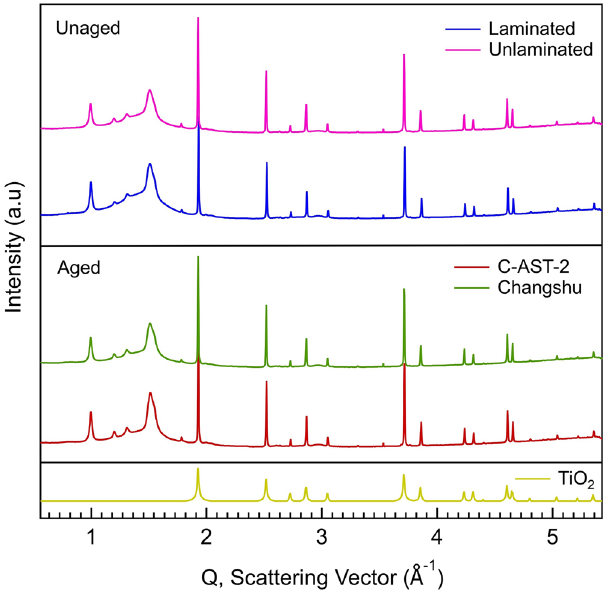
Figure 6. WAXS of unaged and aged AAA backsheets. X-ray scattering of unlaminated (magenta), laminated (blue), C-AST-2 (red), and a representative field aged sample, Changshu (green). The reference pattern for the rutile phase of TiO 2 is included (gold). Q is related to the diffraction angle (θ) and incident wavelength (λ) by Q = (4π/λ) sinθ. The X-ray wavelength used here was λ = 0.9744 Å.